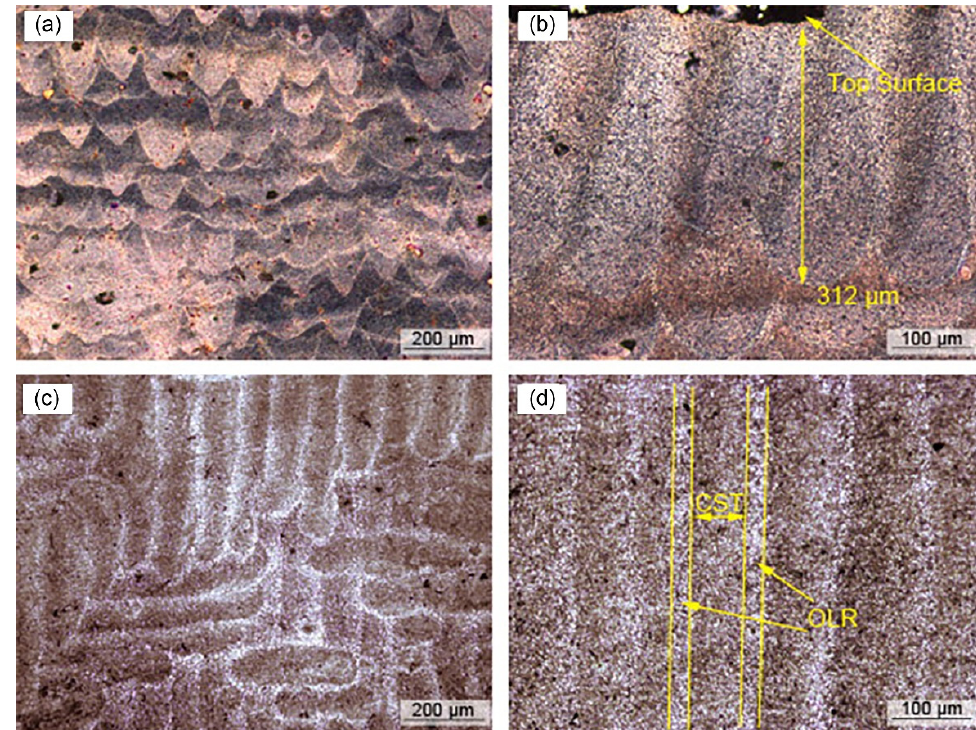
Figure 8. Optical micrographs of the AZ91D sample deposited at Ev of 166.7 J/mm 3 . ( a , b ) The vertical section, ( c ) the cross section, and ( d ) the detail of scanning tracks shown in ( c ). Reprinted with permission from ref. [47]. Copyright 2014 Elsevier.